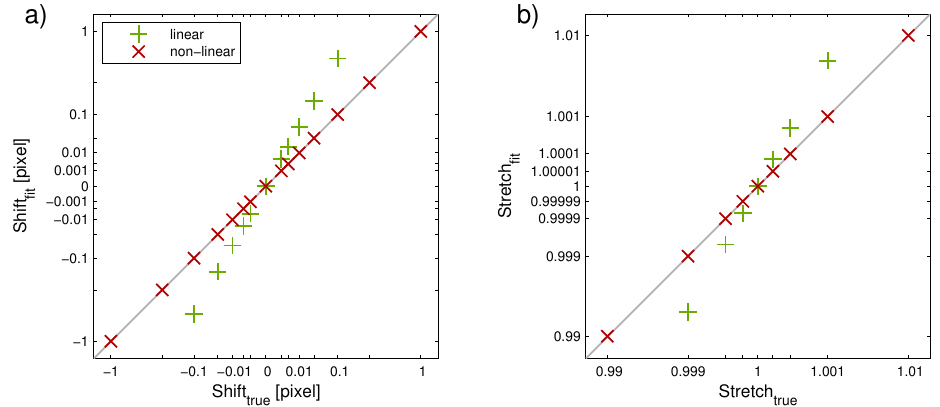
and A σ are off by almost Shift Stretch